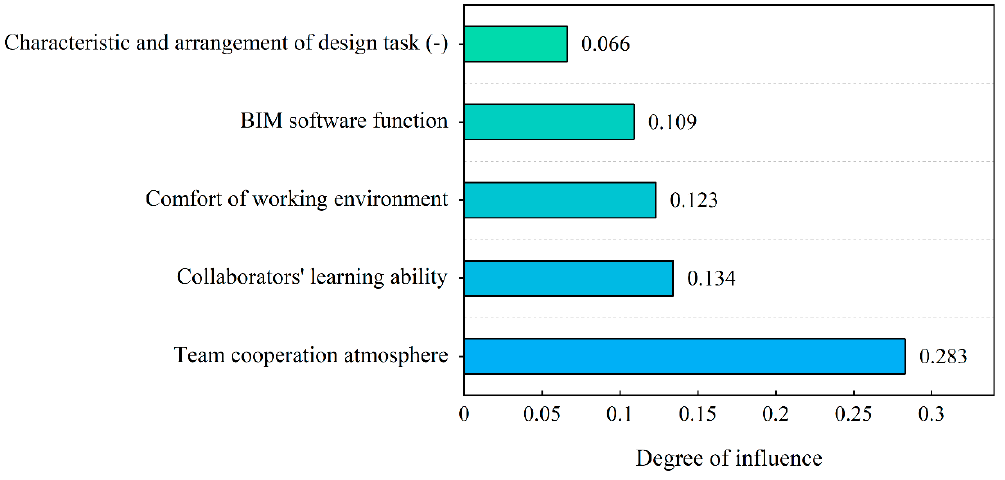
Figure 5. Degree of influence of key factors on teamwork efficiency.